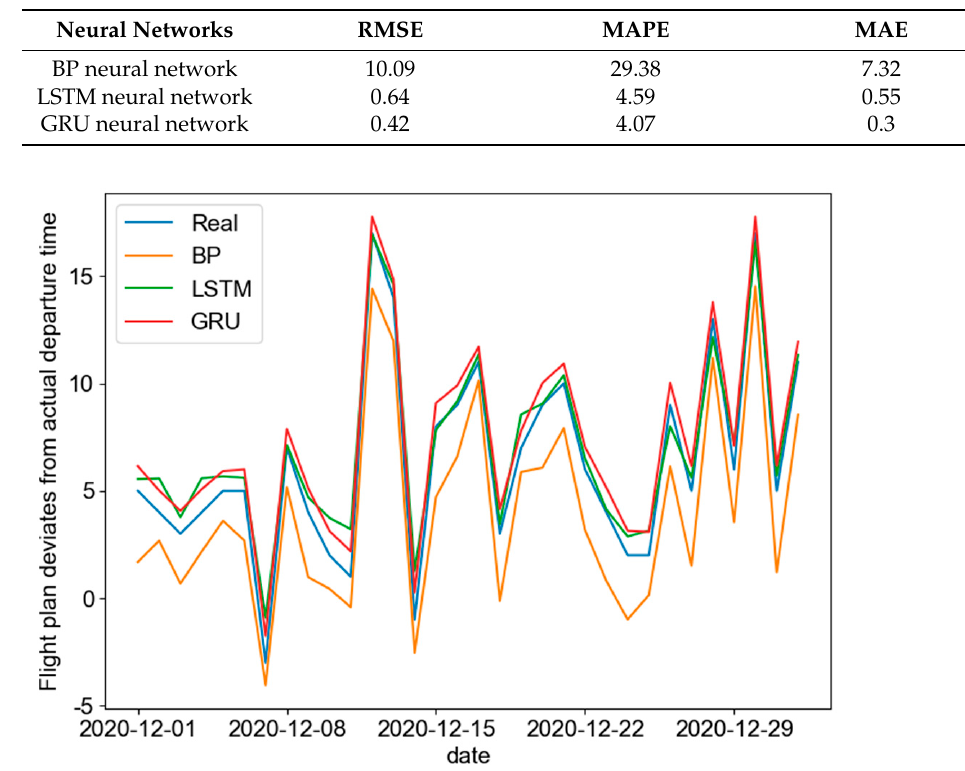
Figure 8. Three kinds of network fitting effect graph.